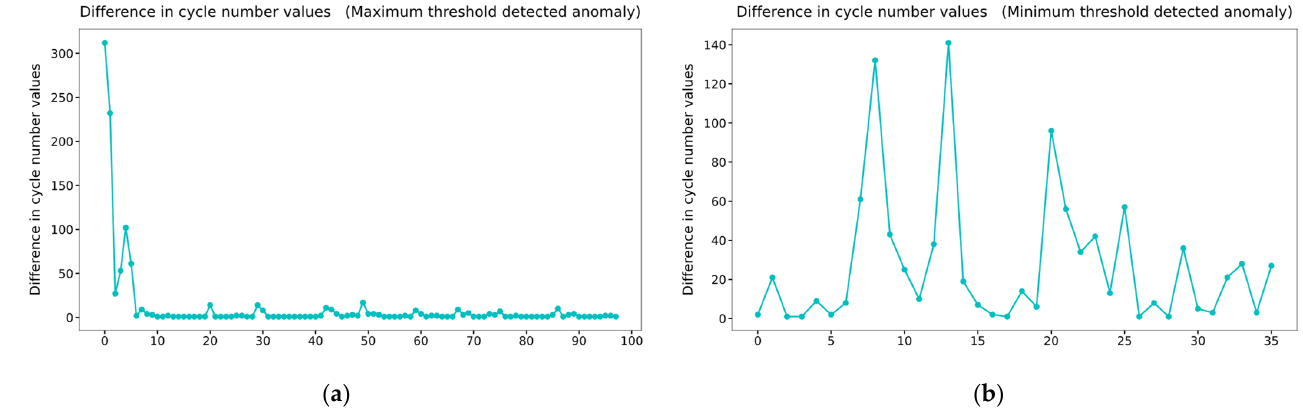
Figure 5. Plotting results of differences in cycle number values. ( a ) Values related to the maximum threshold; ( b ) values related to the minimum